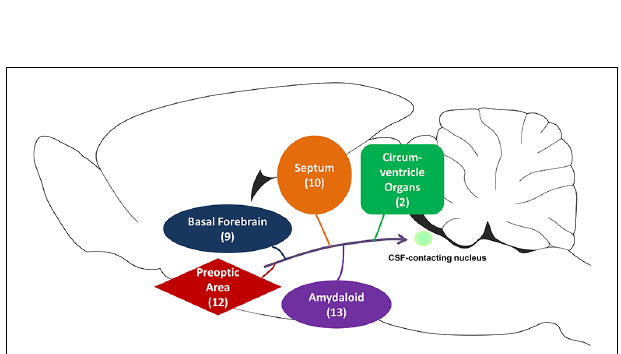
FIGURE 10 | The schematic diagram of projections from the subcortex and limbic system to the CSF-contacting nucleus. Among them, basal forebrain contains nine sub-regions, septum contains 10 sub-regions, circumventricular organs contain two sub-regions, the preoptic area contains 12 sub-regions, and amygdaloid contains 13